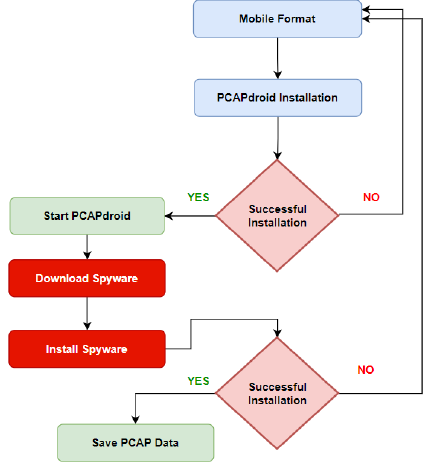
Figure 6. Class B data collection methodology workflow.